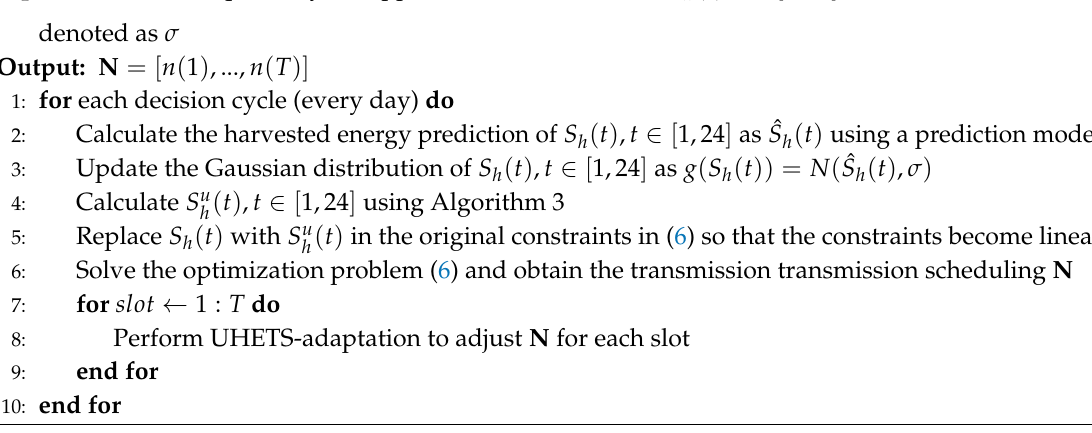
Algorithm 2 Working procedure of